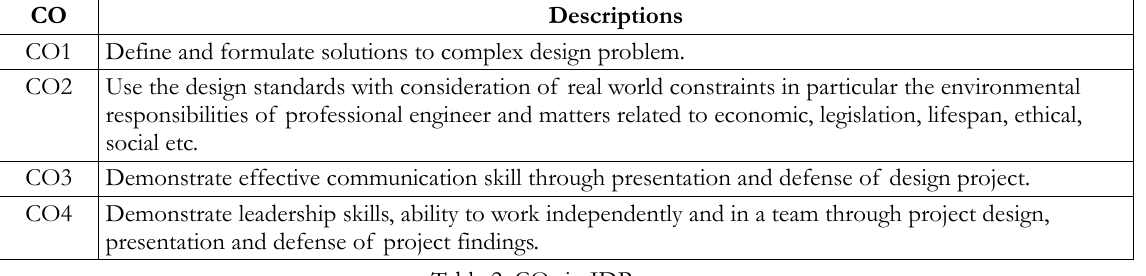
Table 2. COs in IDP course